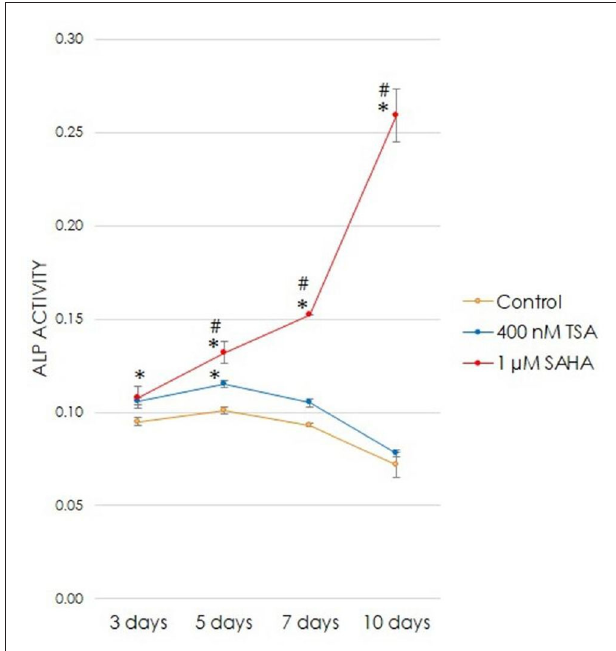
FIGURE 5 | The effect of TSA or SAHA on ALP activity during odontogenesis (one-way ANOVA, Tukey’s HSD post hoc test, Asterisks indicate a significant difference compared with control at p < 0.05, Hashtag s indicate a significant difference between the TSA- and SAHA-treated groups at p < 0.05, n = 4).